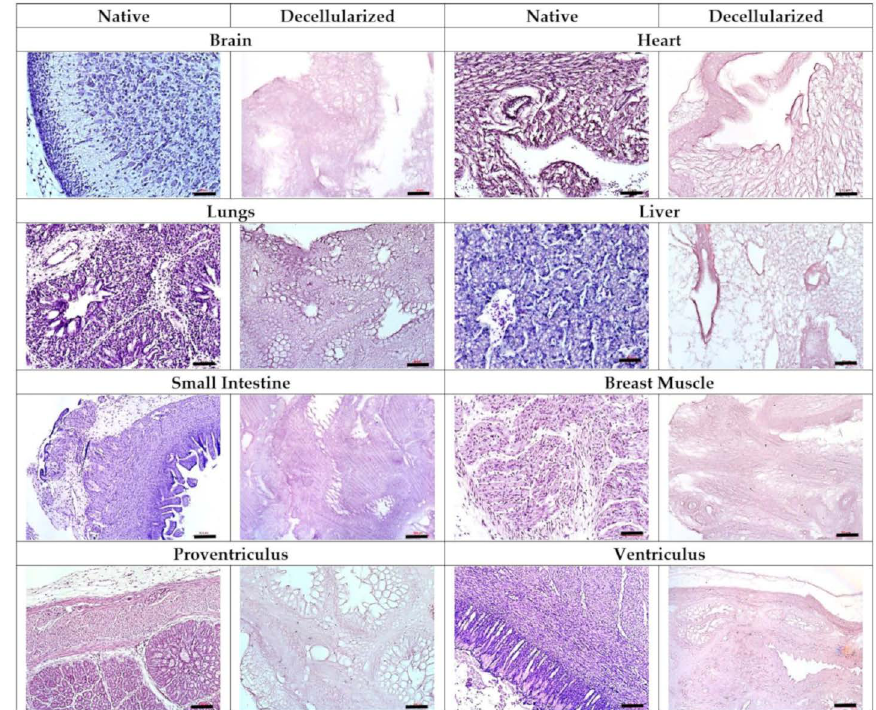
Figure 2. Effect of iWO-DCL on various organs of ED18 CEs. Note complete removal of the cells. The specialized compartments of the organs are recognizable in the matching AOSSs, except the brain AOSSs, where only the ECM areas of different density, with more fibrous (on the left) or more sponge-like (on the right) structures can be seen. In the heart the AOSSs, the myocardium and endocardium compartments are discernible. In the lung AOSSs, the specialized avian pulmonary architecture is preserved, with clearly visible ECMs of parabronchi, alveolar, air capillaries, and the interparabronchial septae. In the liver AOSSs, the elements of former parenchyma (mostly Disse’s space ECMs) and stroma (central and elements of triads) are present. In the small intestine AOSSs, the histoanatomically preserved ECMs of all conventional tissue layers of the organ are visible. The breast muscle AOSSs contain the interchanging areas of the denser and aligned and looser ECM elements corresponding to the distribution of the muscular bands, as well as the ECMs of arteries and veins. The AOSSs obtained from the proventriculi and ventriculi demonstrate excellent preservation of the histoanatomy of the organ layers and glandular elements. Staining with Hematoxylin and Eosin. Scale bars, 50 µ m (brains, hearts, lungs, livers, and breast muscles) and 100 µ m (small intestines, proventriculi, and